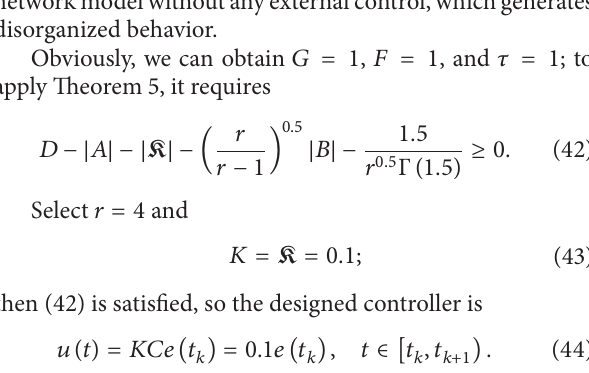
Figure 6: Evolutive behavior of 𝑥(𝑡) and ̂𝑥(𝑡)